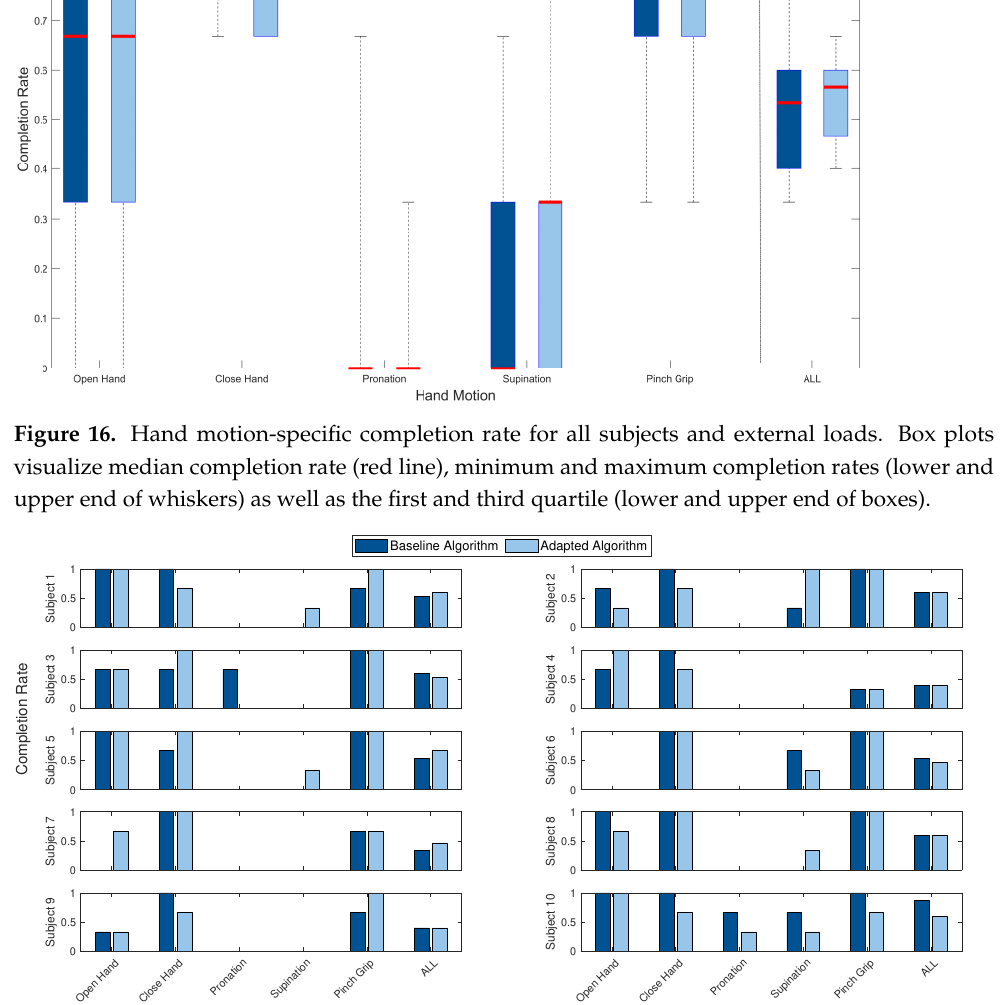
Figure 17. Hand motion-specific completion rate for each individual subject (including all external loads). From left to right: oh , ch , wp , ws and pg